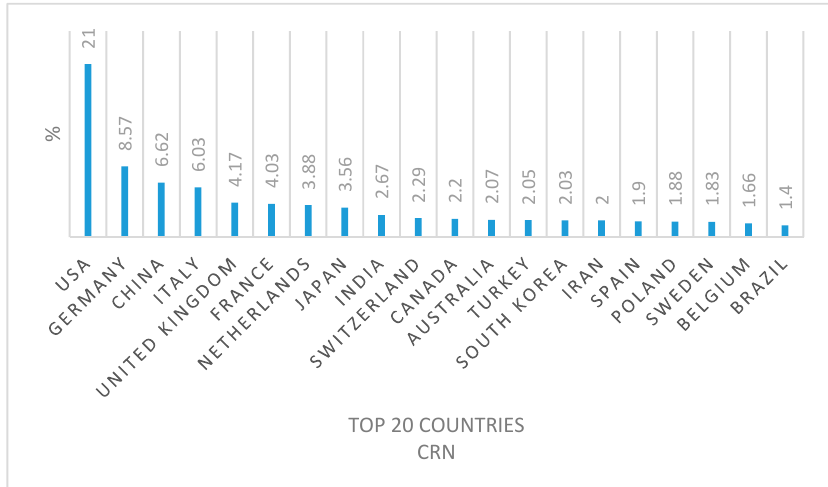
Figure 7. The top 20 countries most contributing to conventional radionuclide publications (2008–2018).